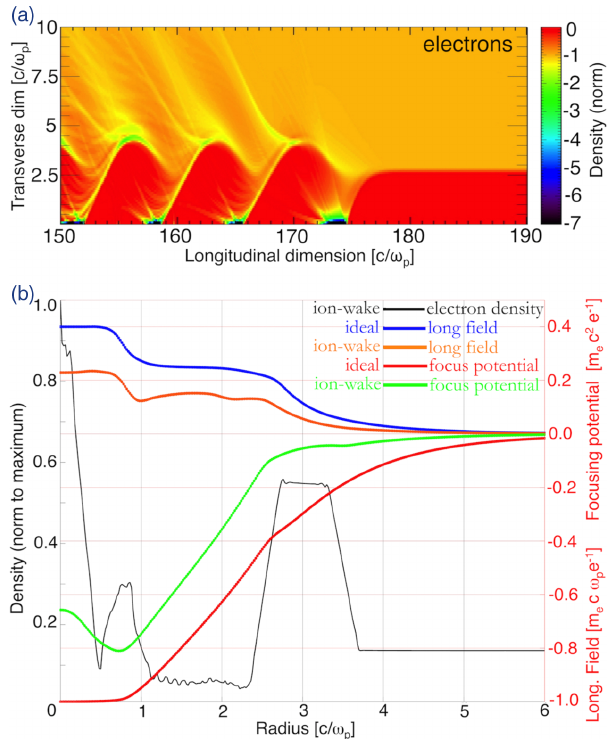
FIG. 8. 2D-PIC simulations: (a) electron density in real space showing electron density excitation in the crunch-in regime; (b) corresponding radial profile of fields excited by a positron beam in an ideal-channel versus an ion-wake channel. The radial profile of the normalized electron density (black) in an ion-wake channel (normalized to the maximum electron com- pression) at longitudinal location of the peak accelerating field ¼ 2 . 3 c= ω ¼ 380 00 , n ¼ 1 . 3 n ( r , γ 0 ). The radial profile pb pe pb pb of the accelerating field and the normalized potential of the focusing field ( E - B θ ) (radial field integrated from the edge of the r box to a radius on